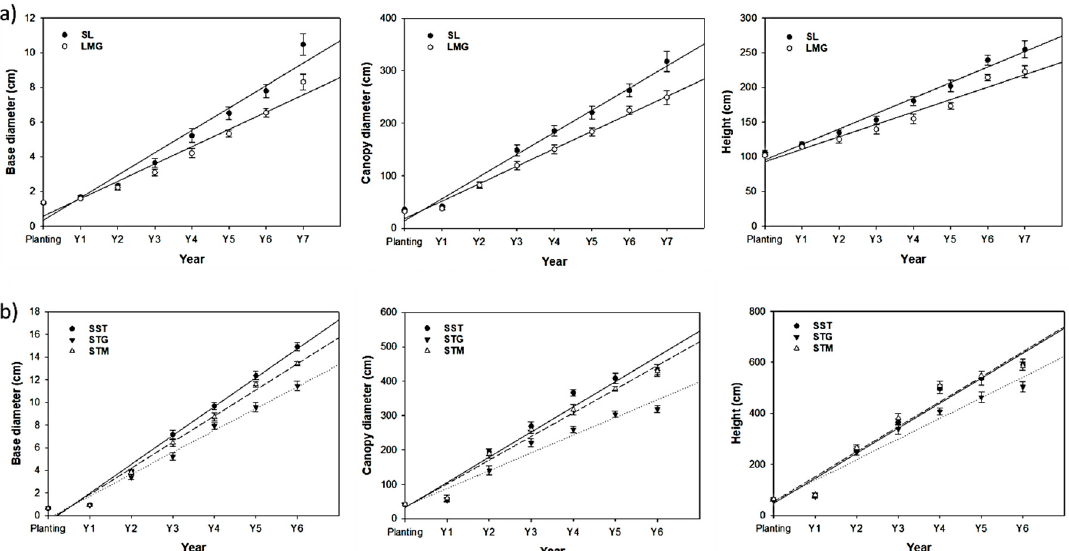
Figure 3. Regression lines describing tree growth (mean and standard error): ( a ) Growth of longan in the sole-tree system (SL) and longan–maize–forage grass (LMG) system; ( b ) growth of son tra in the sole-tree system (SST), son tra–guinea grass (STG) system, and son tra–mulato grass (STM) system.